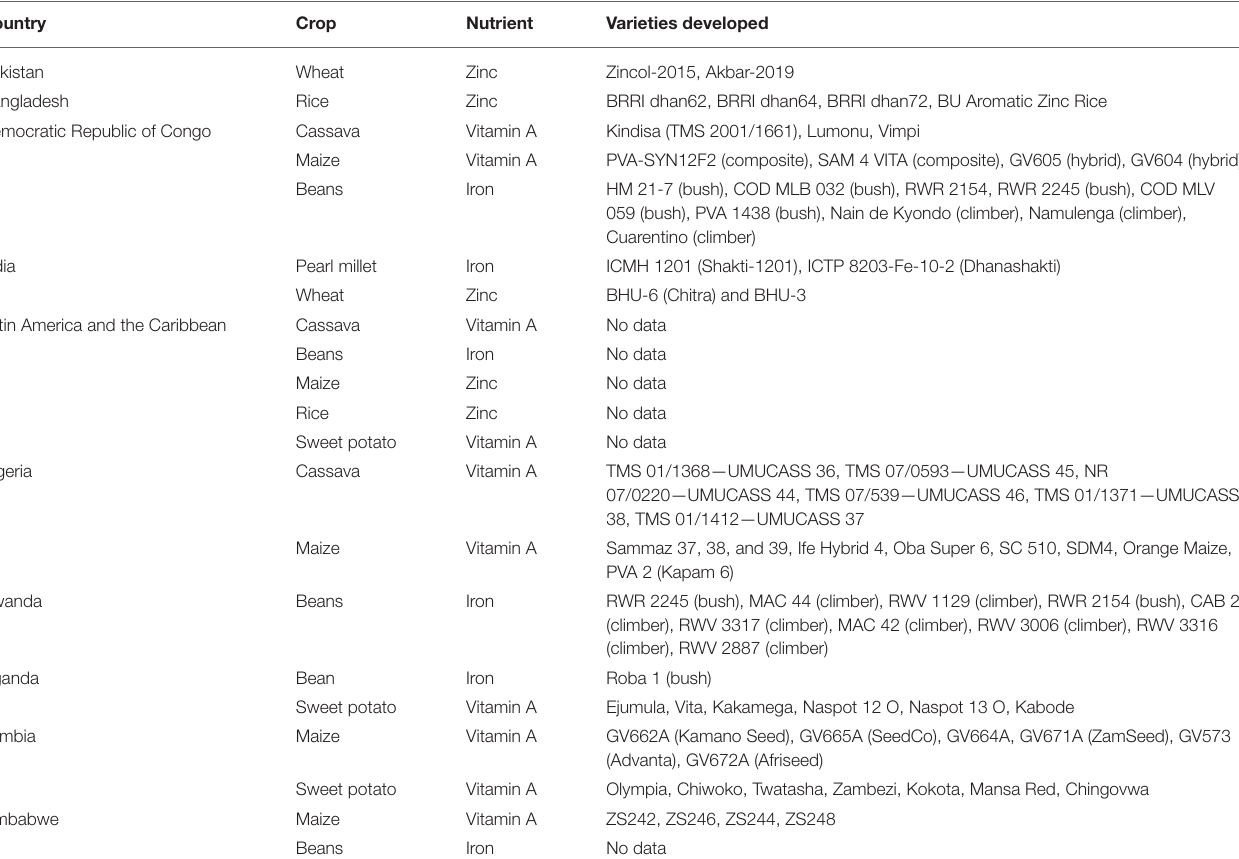
TABLE 2 | Summary of ongoing activities and achievement of HarvestPlus program.